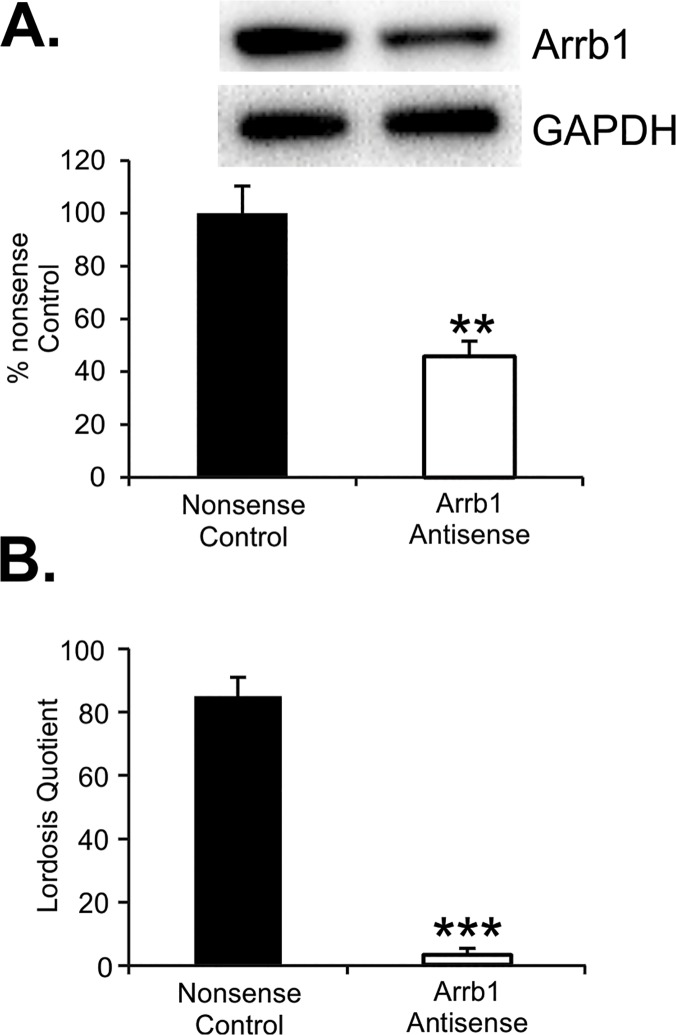
Arrb1 mediates EB-induced lordosis behavior.
In vivo, Arrb1 asODN significantly reduced levels of Arrb1 in the ARH of ovariectomized, EB-treated rats. (A) Arrb1 protein levels in ARH lysates from females microinjected on four consecutive days with Arrb1 asODN versus females microinjected with nsODNs. (B) Lordosis quotient from rats injected with nsODNs vs. Arrb1 asODNs. Values represent means (n = 8–10 animals) ± SEM. ** (p<0.005). ***(p<0.0001).